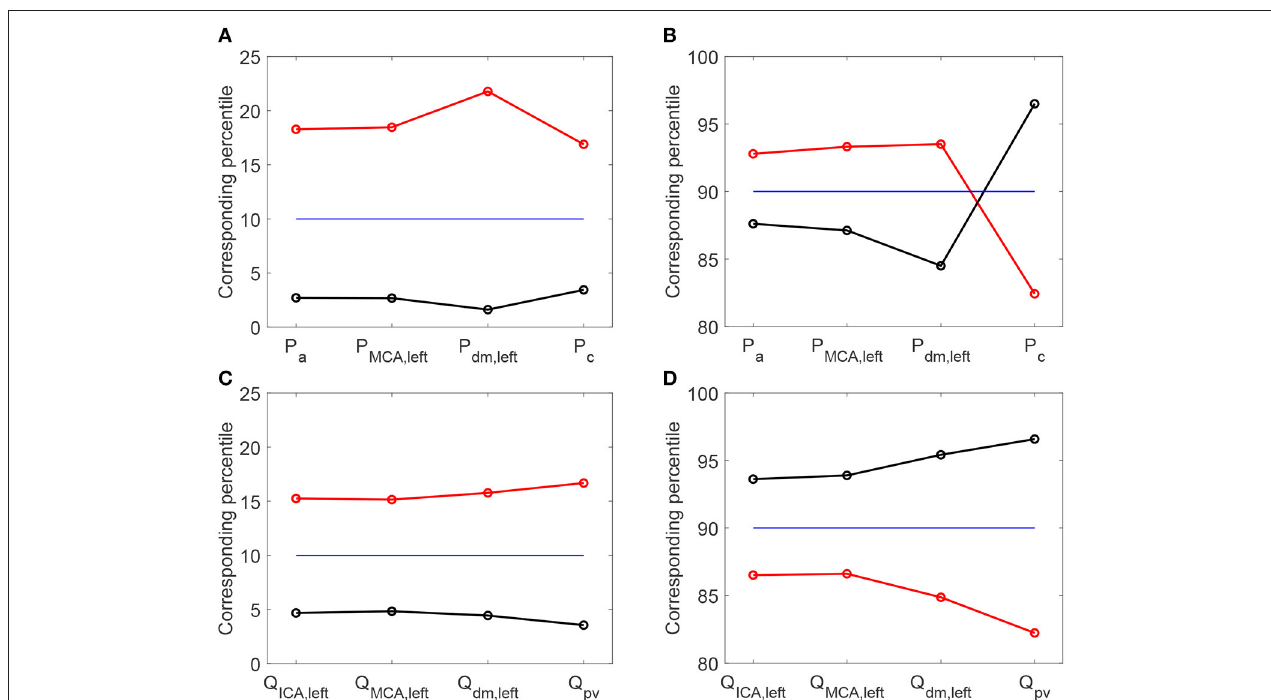
FIGURE 5 | Percentile values in increased (red) and decreased (black) HRV to which the 10th (A,C) and 90th (B,D) percentiles in baseline configuration correspond. Pressure (A,B) and flow rate (C,D) along the ICA-MCA pathway.